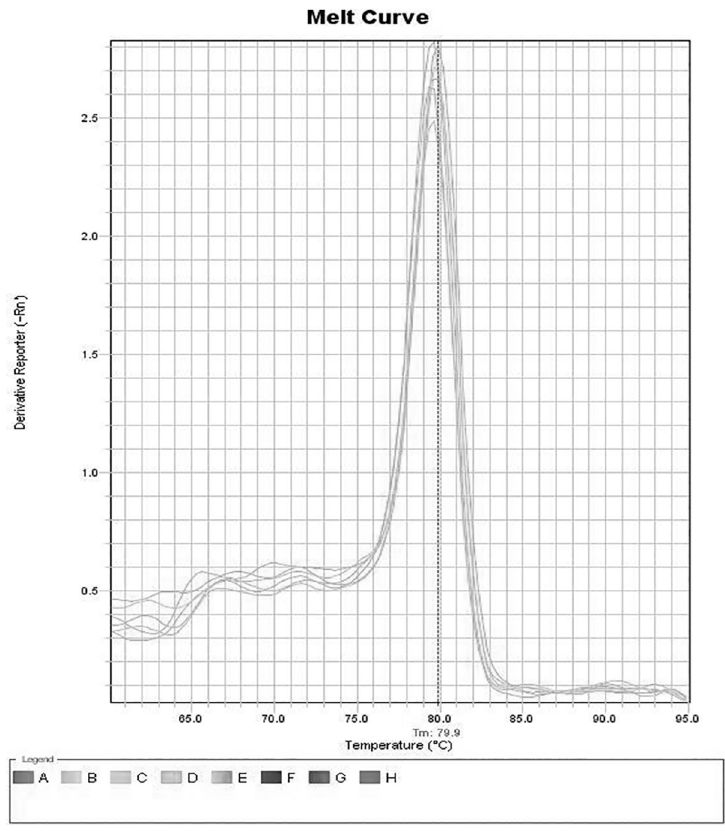
Fig 8. Melt curve of 18 S rRNA primers employed as an internal control (GenBank Accession No. AF156675) for qRT-PCR analysis of various T1 transgenic progeny plants of rice.